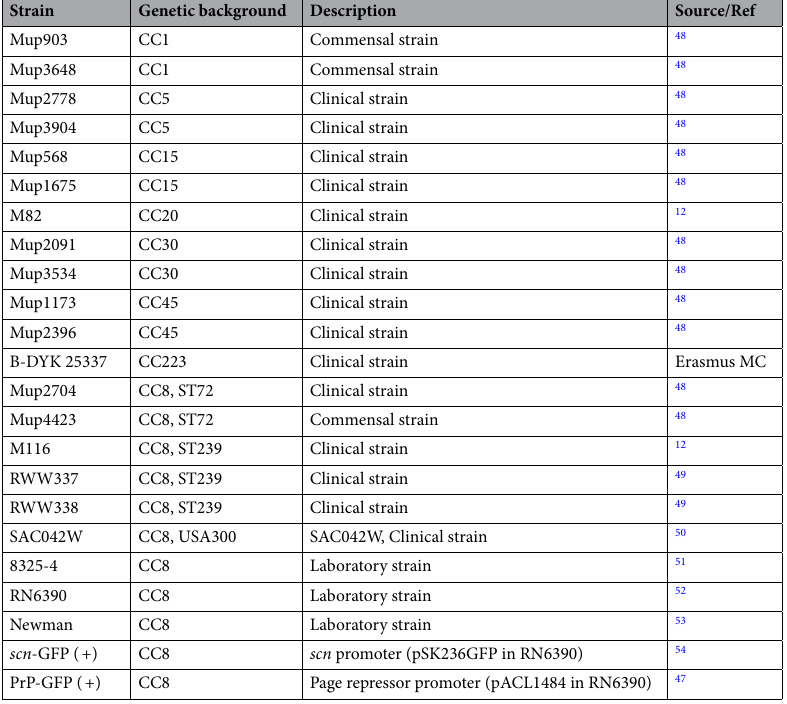
Table 1. S. aureus strains used in this